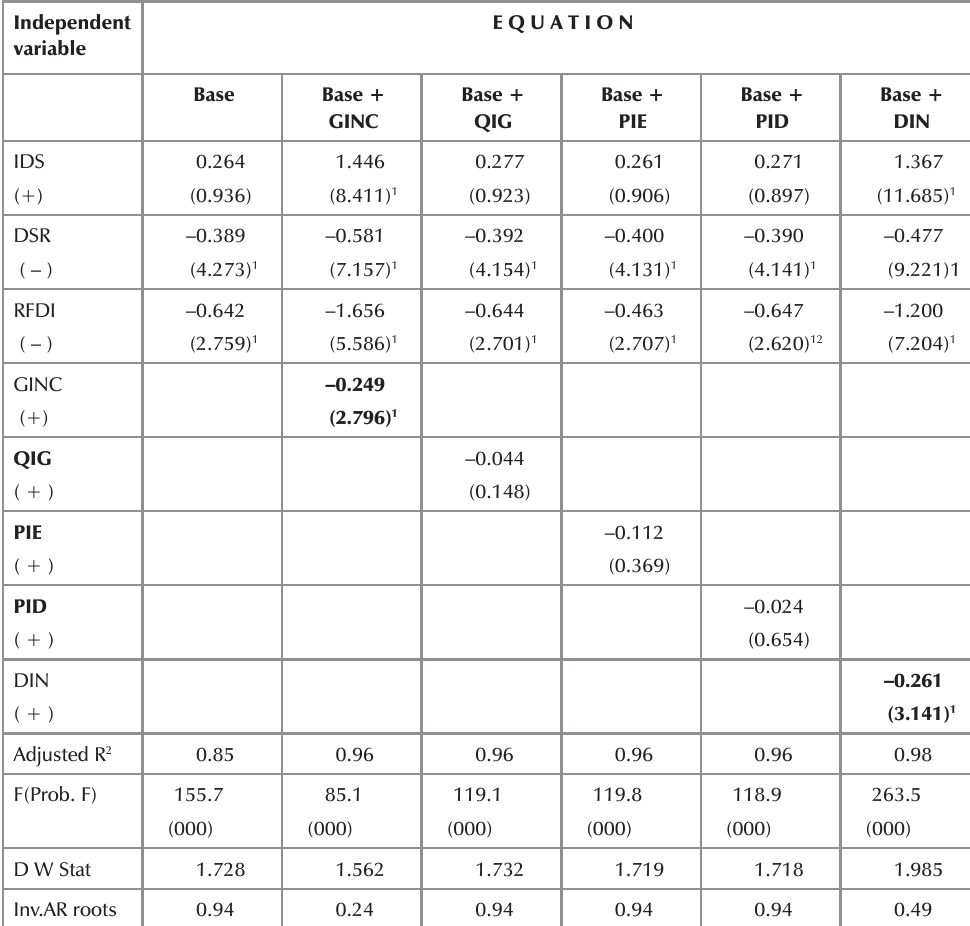
Regression of gross domestic savings in nominal terms on the level of democratisation Dependent variable = lnGDS; [N= 27]